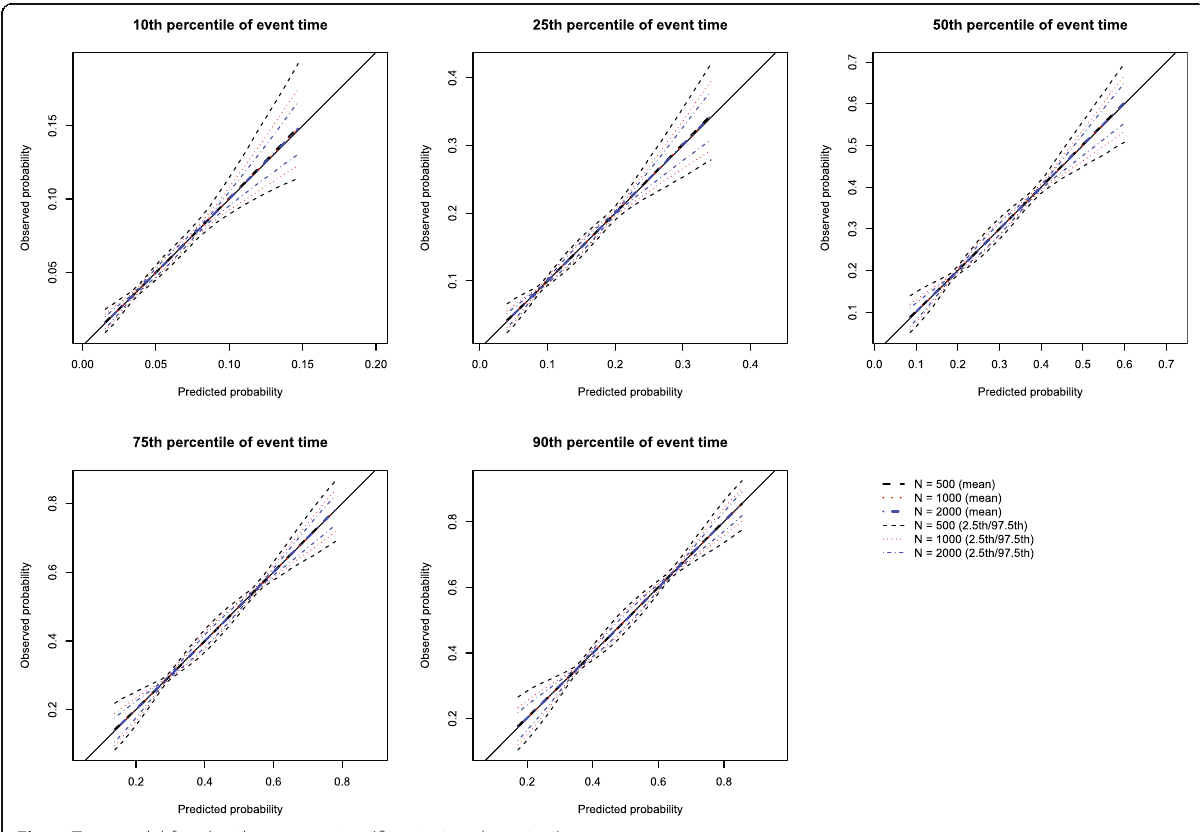
Fig. 5 True model fitted with no censoring ( β 1 = 0.50 and p =